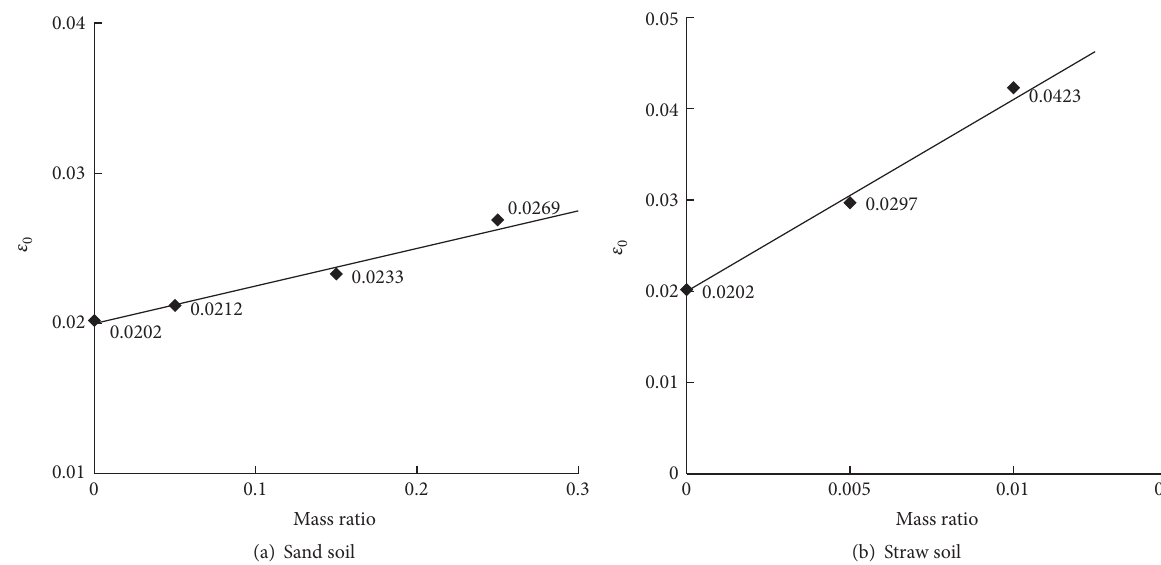
Figure 12: Relationships between stress and additive content of sand soil and straw